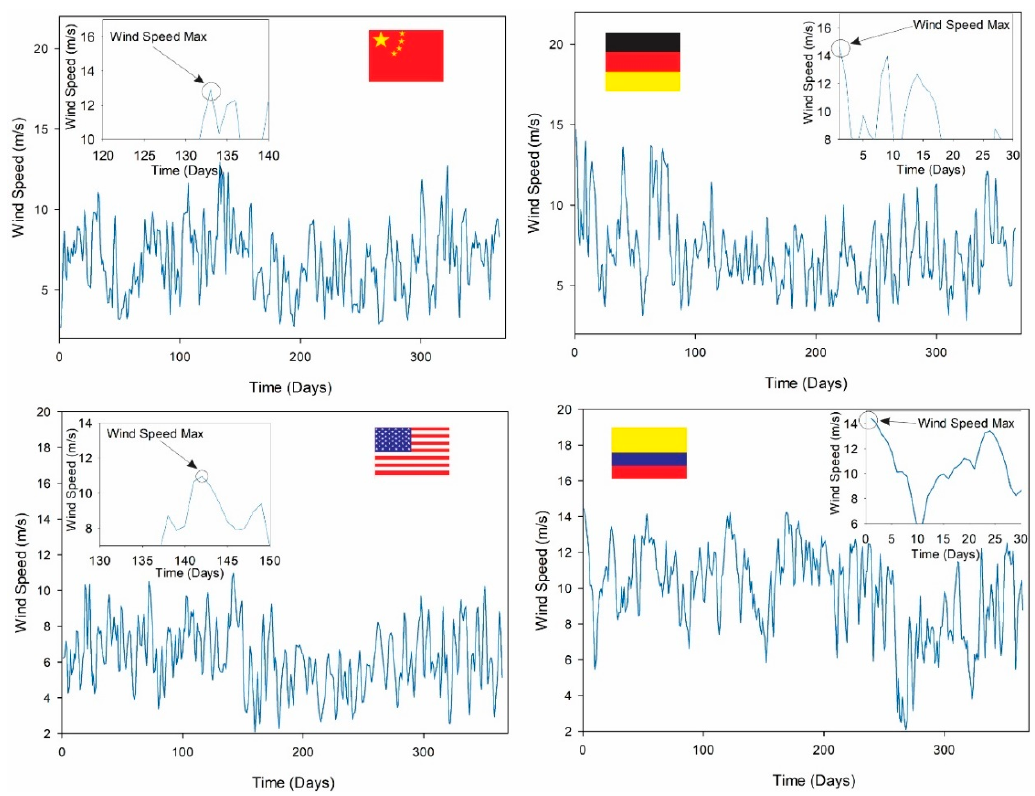
Figure 5. Wind speeds for each location.